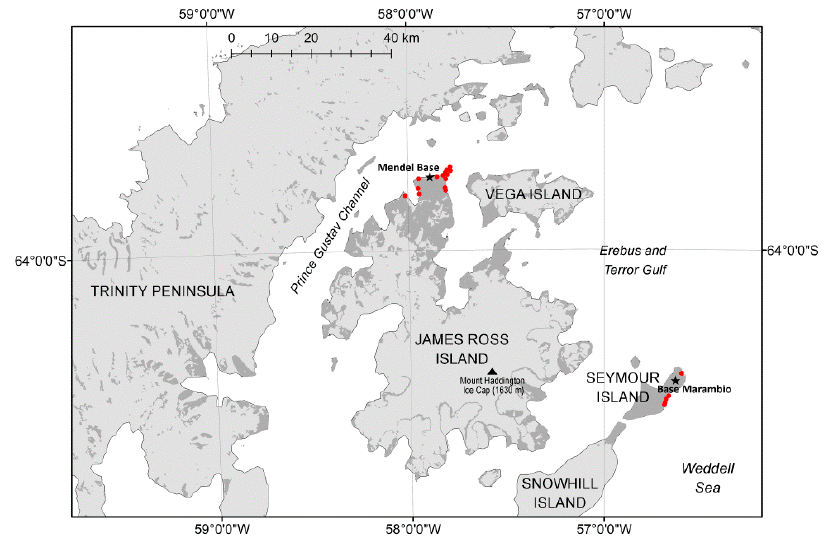
Figure 1. Sampling localities on James Ross Island and Seymour Island. Red mark, location of sampling site; asterisk, location of Antarctic base station; dark grey color, unglaciated area.